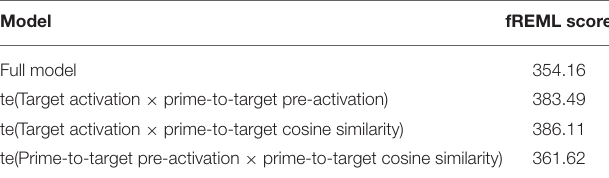
TABLE 6 | fREML scores for four models: the full model, a model without Prime-to-Target Cosine Similarity, a model without Prime-to-Target Pre-Activation, and a model without Target